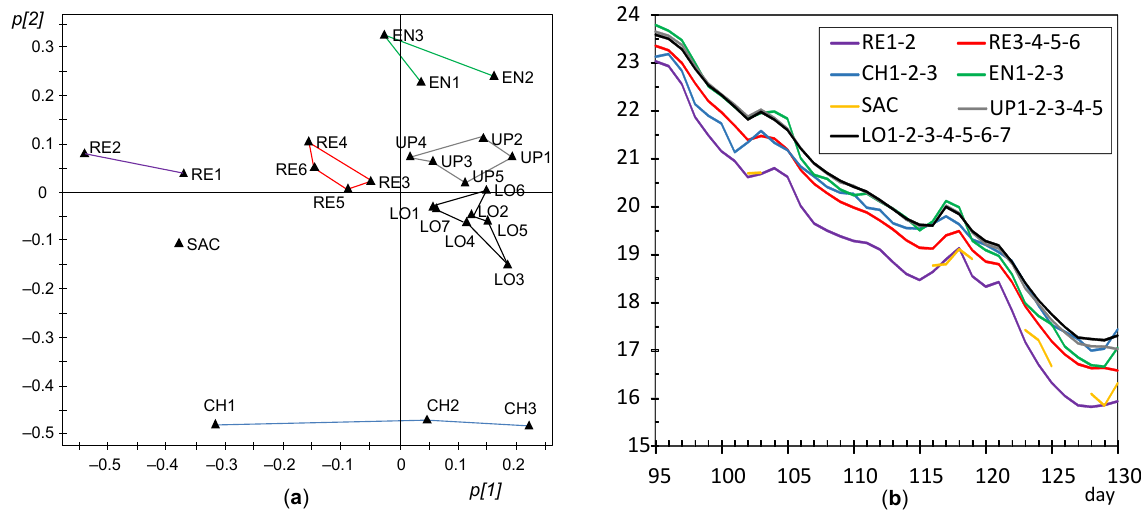
Figure 22. PCA of daily medians for the period of days 95–130 after discarding node OUT: ( a ) loading plot for PC1 and PC2 ( p[2] vs. p[1] loadings), ( b ): time series of daily median temperatures from day 95–130. Trajectories were averaged according to clusters indicated in ( a ).